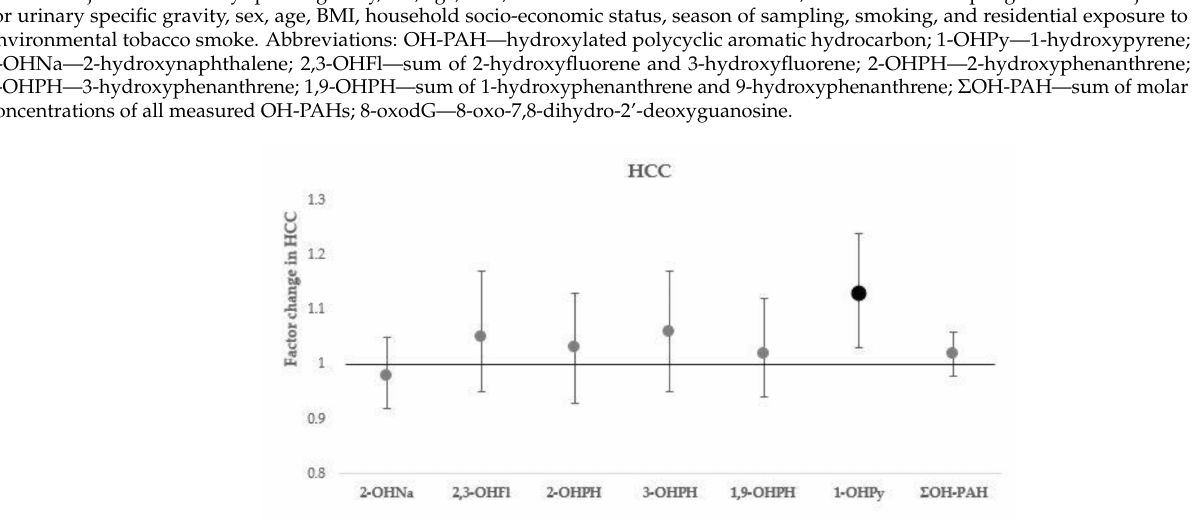
Figure 1. Associations of urinary OH-PAHs concentration with HCC. Effect estimates are presented with their 95% confidence interval (95% CI) as the factor change in HCC for a doubling in OH-PAH